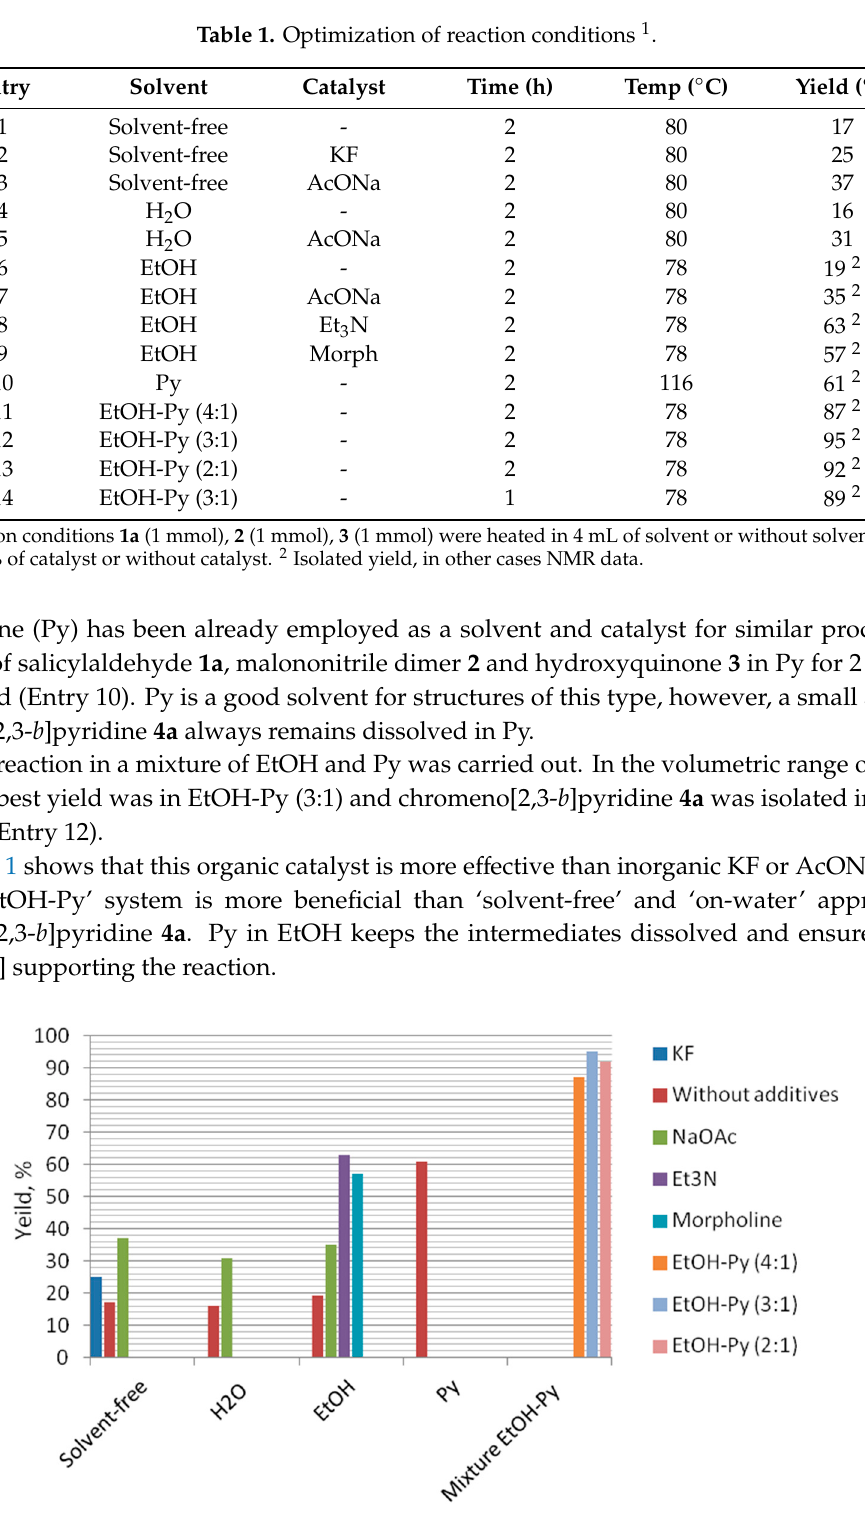
Table 1. Optimization of reaction conditions 1 .